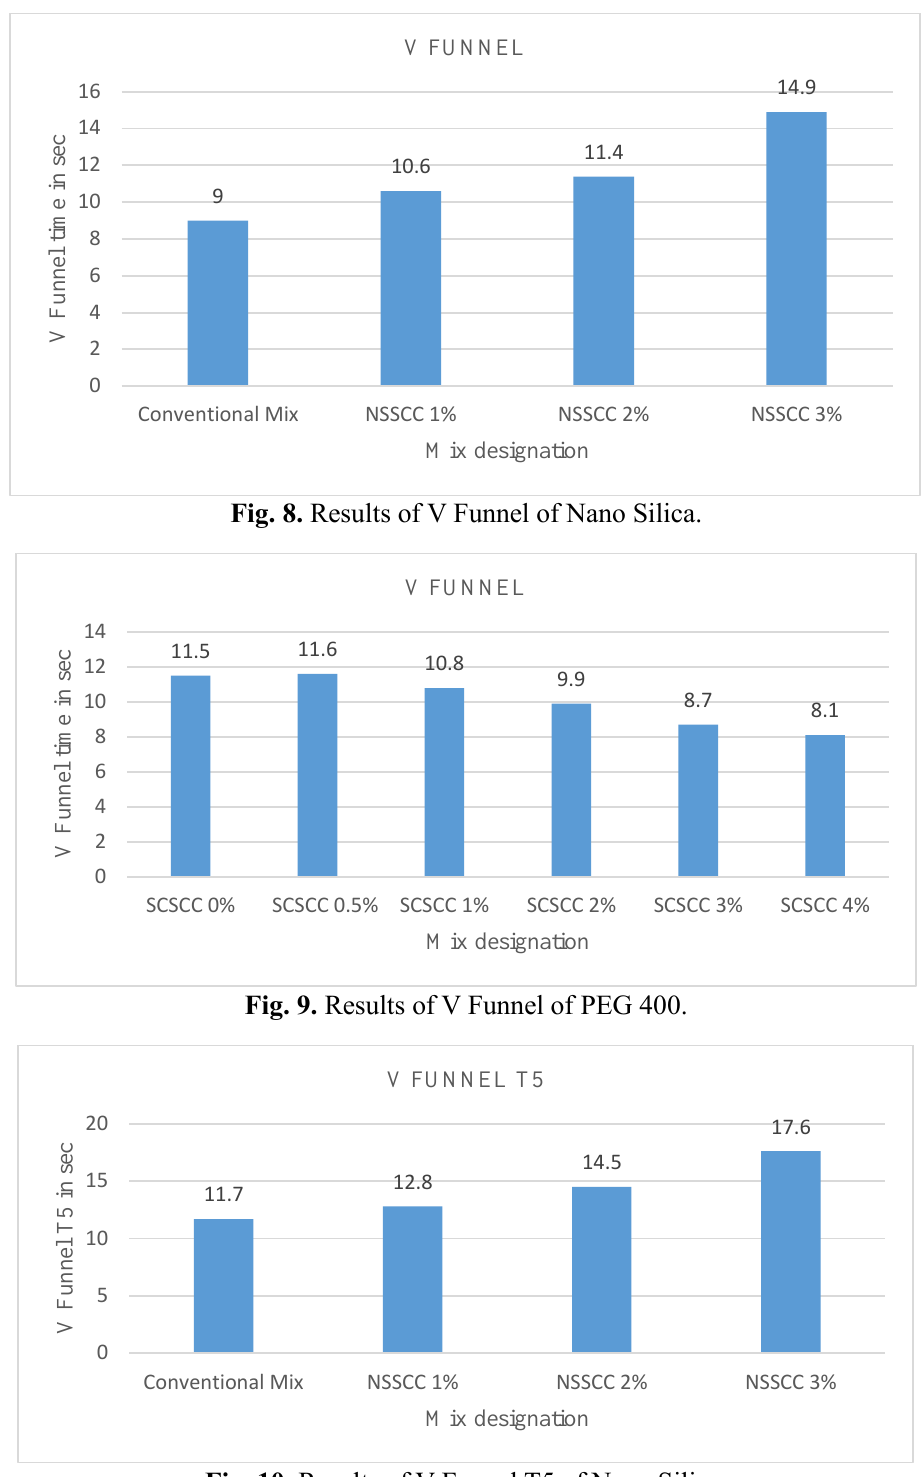
Fig. 10. Results of V Funnel T5 of Nano